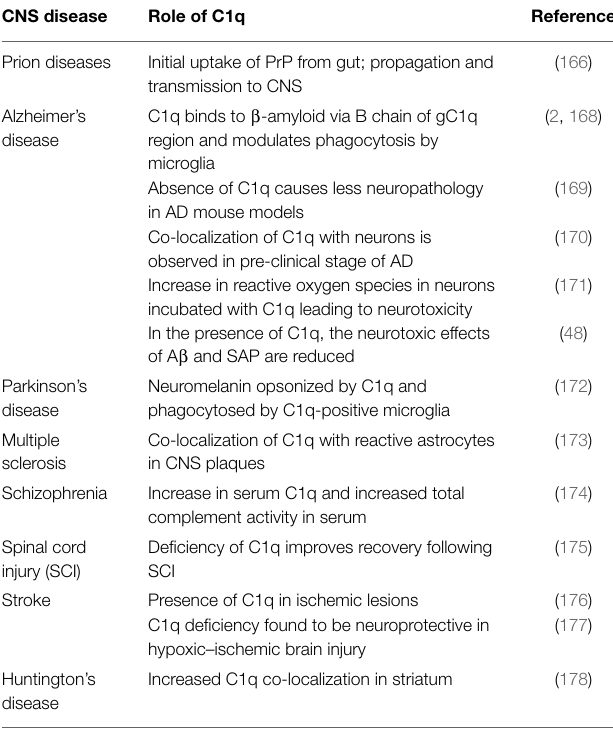
TABLE 2 | Role of C1q in CNS diseases